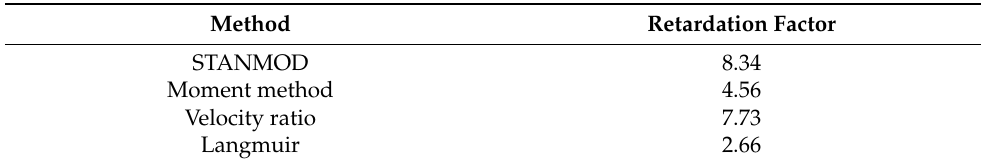
Table 3. Estimation of the retardation factor with different methods for the transport experiment performed with 1000 mg L − 1 of initial TC concentration.